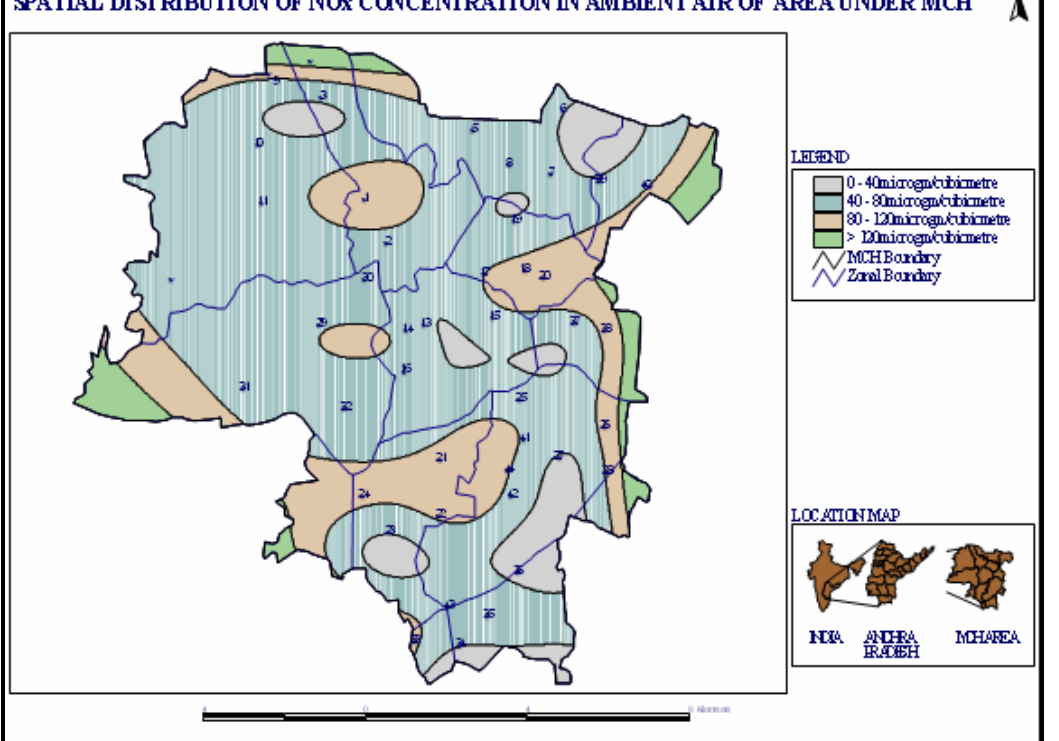
Figure 3: Spatial distributions of oxides of nitrogen concentration in Municipal Corporation of Hyderabad